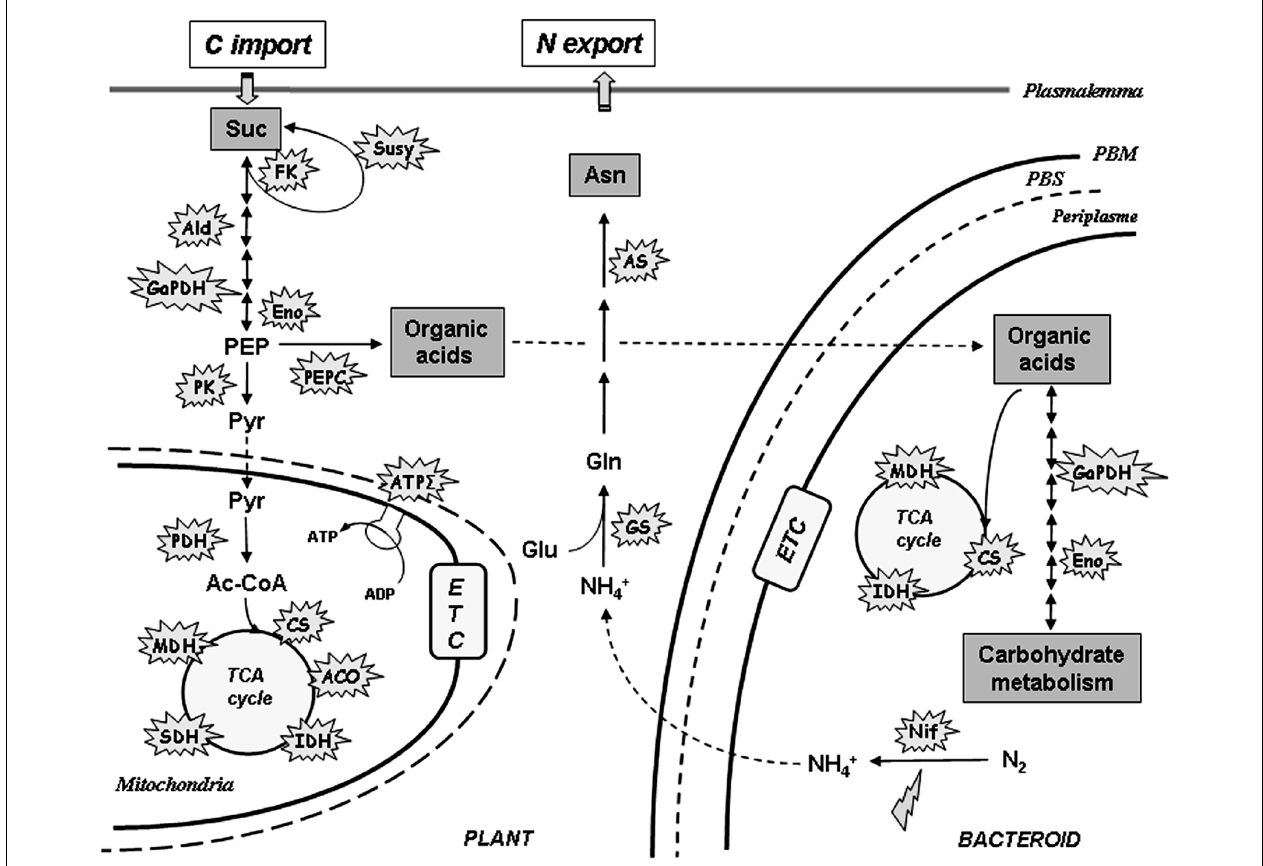
FIGURE 2 | Schematic representation of NO targets in nitrogen, carbon, and energy metabolism in nitrogen-fixing nodules. Explosions refer to enzymes from both plant and bacterial partners found to be either S -nitro- sylated, or/and inhibited, by NO. Lightning refers to gene repression by NO. Ac-CoA, acetyl-CoA; Asn, asparagine; Glu, glutamate; Gln, glutamine; NH + 4 , ammonium; PEP, phosphoenolpyruvate; Pyr, pyruvate; Suc, sucrose. Aco, aconitase; Ald, aldolase; AS, asparagine synthetase; ATP (cid:2) , ATP synthase;